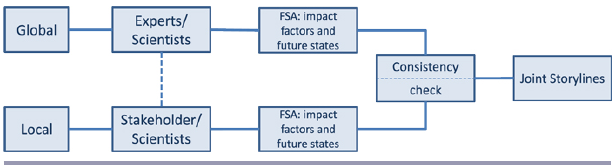
Fig. 2 . Illustration of the study area showing main land use types and four subregions: the valley entrance to the city of Visp (A), historical houses (B), glaciers tourism above Saas- Fee (C), and a forested area (D). Pictures were taken by the project team. In 2009, agriculture accounted for 4023 ha (11.7% of the whole region), forested/wooded areas 7631 ha (22.2%), settlement/urban 853 ha (2.5%), unproductive vegetation areas 3837 ha (11.2%), bare land (glaciers and rocky surfaces) 17,464 ha (50.8%), and water surface 541 ha (1.6%).